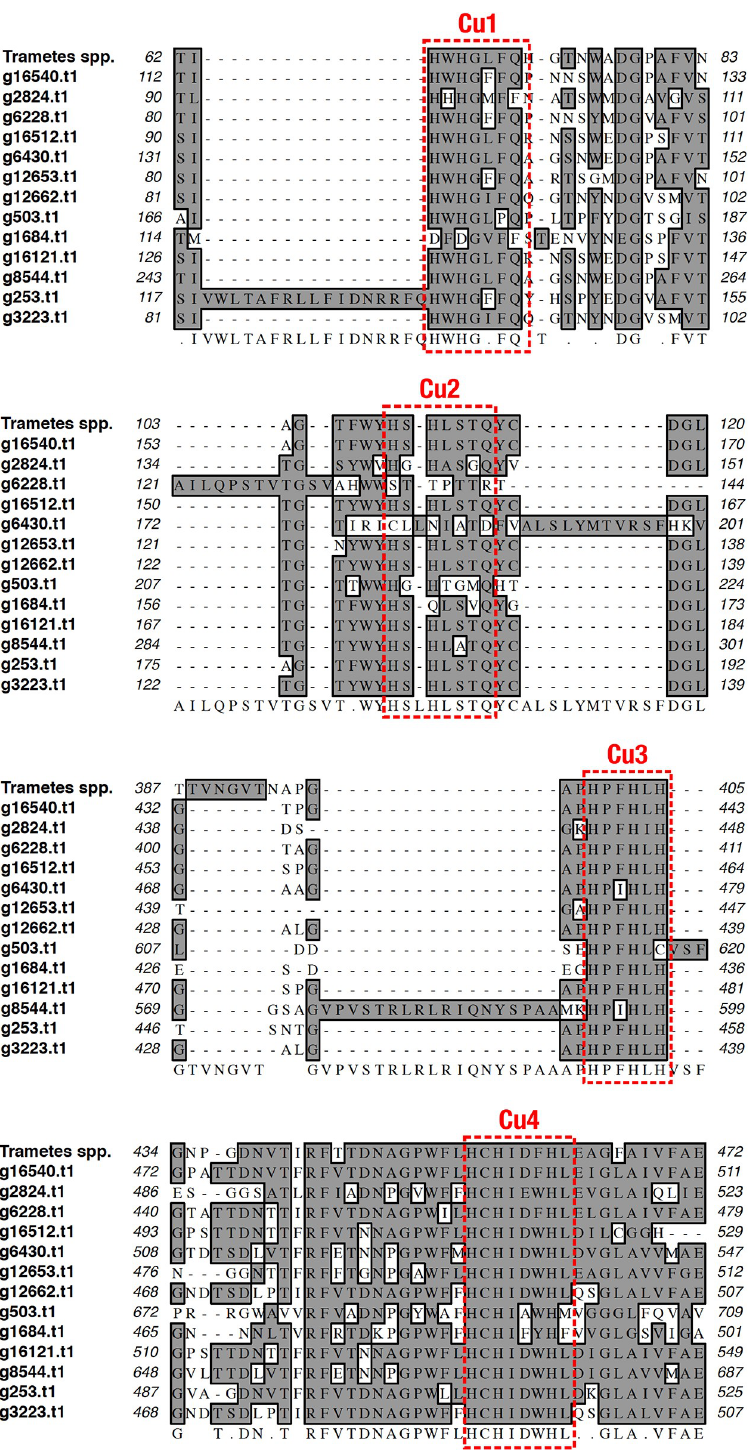
Fig 7. Multiple Sequence Alignment (MSA) of the 13 putative laccases identified in the genome of Dictyopanus pusillus LMB4. The four conserved copper-binding motifs are highlighted by red dashed rectangles. The laccase sequence of the Trametes genus was used as reference to perform the MSA. Consensus sequence is presented on the bottom of the alignment. Putative laccase genes are identified as in S1 Table in S1